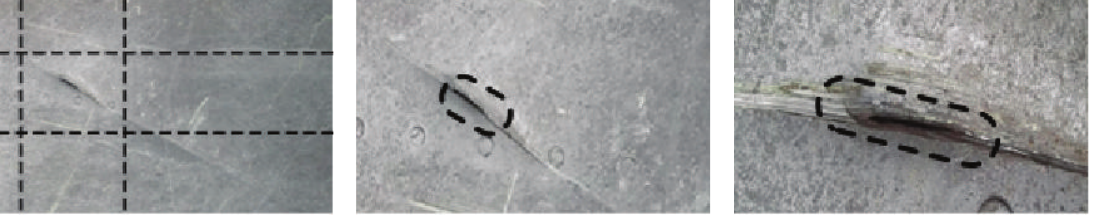
Figure 7: Schematic defect location.